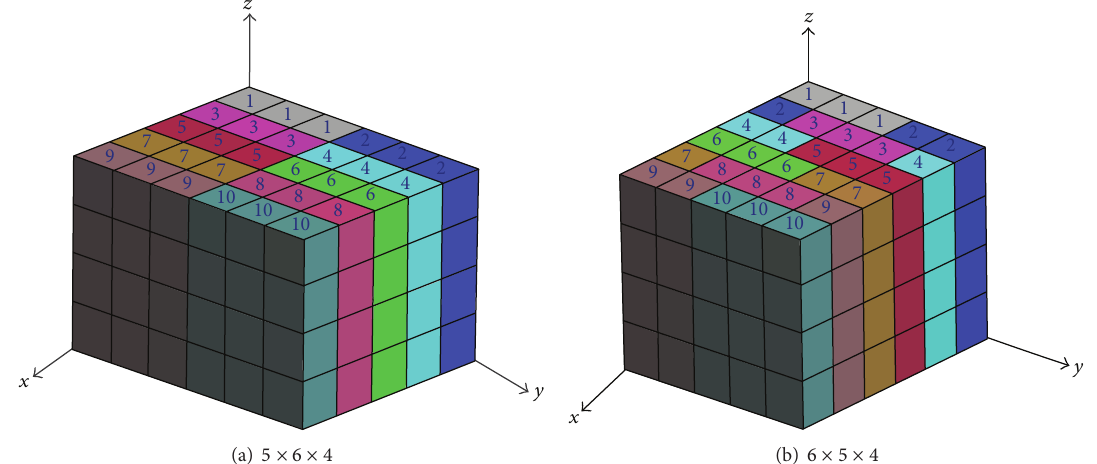
Figure 4: The diagram of communication mode across nodes between the virtual topologies 5 × 6 × 4 and 6 × 5 × 4 .